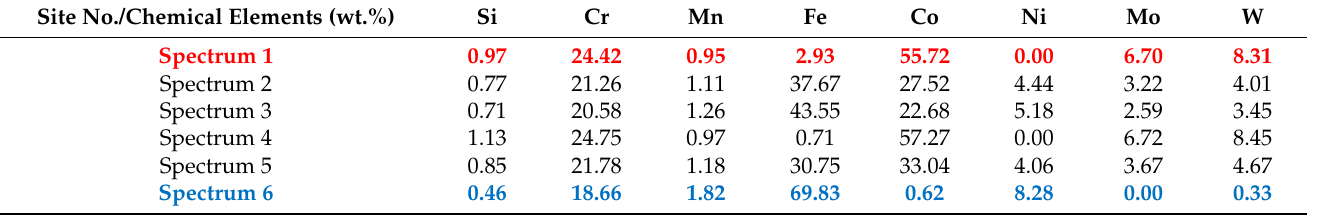
Figure 12. CoCr – 304 interface maps based on main chemical elements (in wt.%) and their distribu- tion: ( a ) SEM image; ( b ) EDAX maps for W, Ni, Cr, Fe, Mo, and Co. Figure 13. CoCr – 304 interface in SEM image used for EDAX point measurements detailed in Table 5. Table 5. EDAX point measurement data for sites indicated in Figure 13. Red color indicates CoCr alloy composition; blue color indicates 304 stainless steel composition.